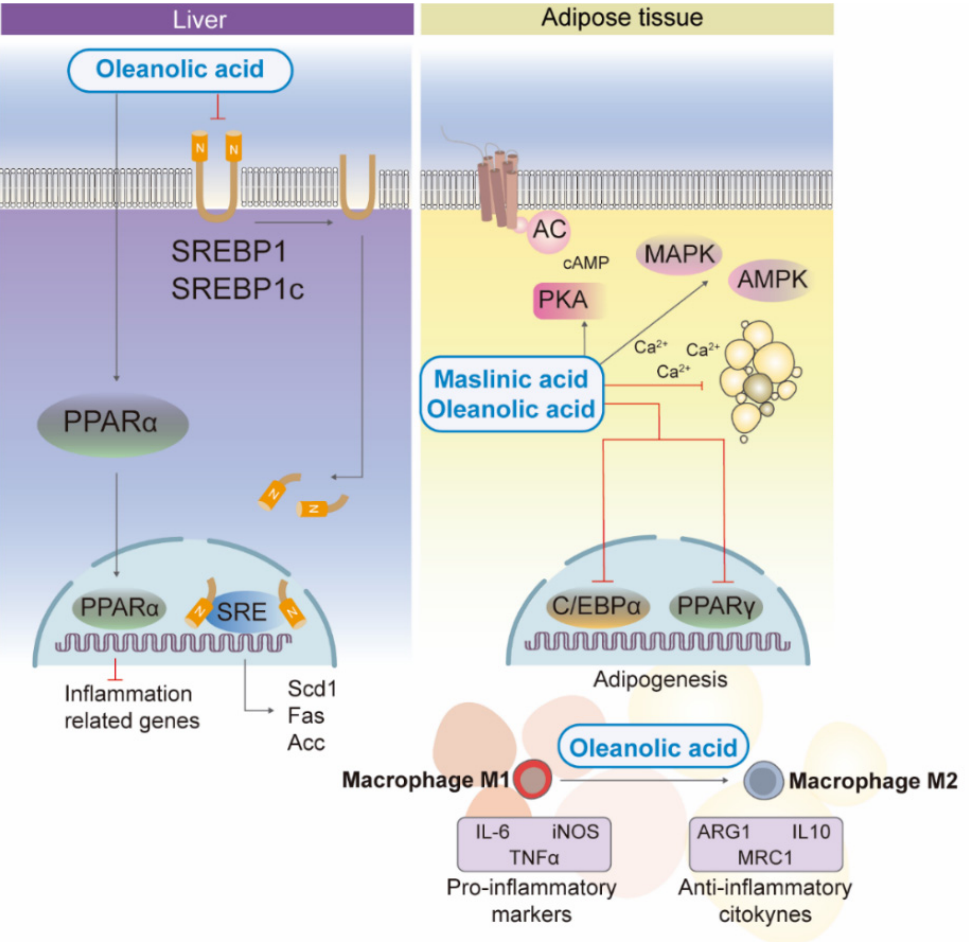
Figure 3. Effects of triterpenic acids on lipid homeostasis and adiposity in liver and white adipose tissue and in brain cells. In the liver, oleanolic acid inhibits the expression of SREBP1-responsive genes and promotes the expression of PPAR α leading to anti-inflammatory effects in animal models of obesity. In the adipose tissue, oleanolic and maslinic acids interfere in different steps of adipogenesis and lipolysis by down-regulation of the expression of C/EBP α and PPAR γ , and by modulating anti- adipogenic pathways and kinases (MAPK, AMPK, and cAMP-dependent PKA). Oleanolic acid also attenuates inflammation in adipose tissue by diverting macrophage infiltration and polarization to the anti-inflammatory M2 phenotype. SREBP1, sterol regulatory element-binding protein 1; SREBP1c, sterol regulatory element-binding protein-1c; SRE, sterol regulatory element; Scd1, stearoyl coenzyme A desaturase 1; Fas, fatty acid synthase; Acc, acetyl-coenzyme A carboxylase; AC, adenylyl cyclase; cAMP, cyclic adenosine monophosphate; PKA, protein kinase A; MAPK, mitogen-activated protein kinases; AMPK, adenosine monophosphate activated protein kinase; Ca 2+ , calcium ions; C/EBP α , cytosine-cytosine-adenosine-adenosine-thymidine (CCAAT) enhancer-binding protein alpha; M1 and M2, phenotype macrophages; IL-6, interleukin 6; iNOS, inducible nitric oxide synthase; TNF α , tumor necrosis factor alpha; ARG1, arginase 1; IL10, interleukin 10; MRC1, mannose receptor C-type